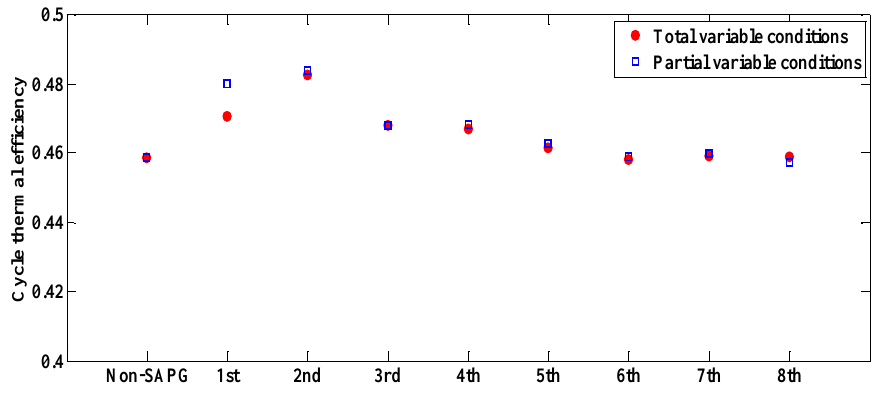
Figure 9. Replace each stage of cycle thermal efficiency.